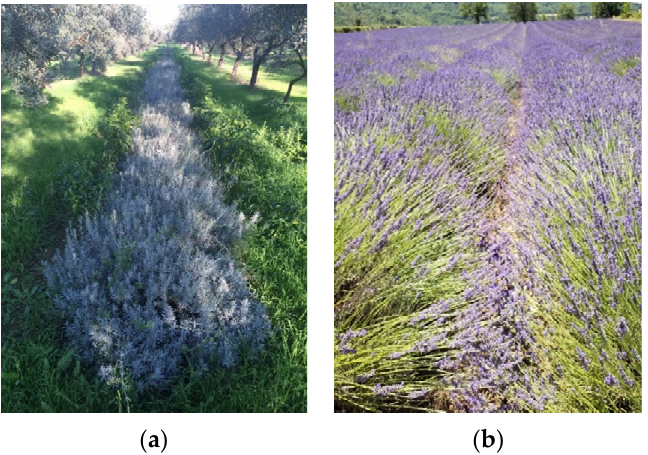
Figure 6. Two examples of the lavender plants sampled in this work. ( a ) LaPE (springtime), Rosciano, Italy, and ( b ) LaPRV, (summertime) Provence Region, France.